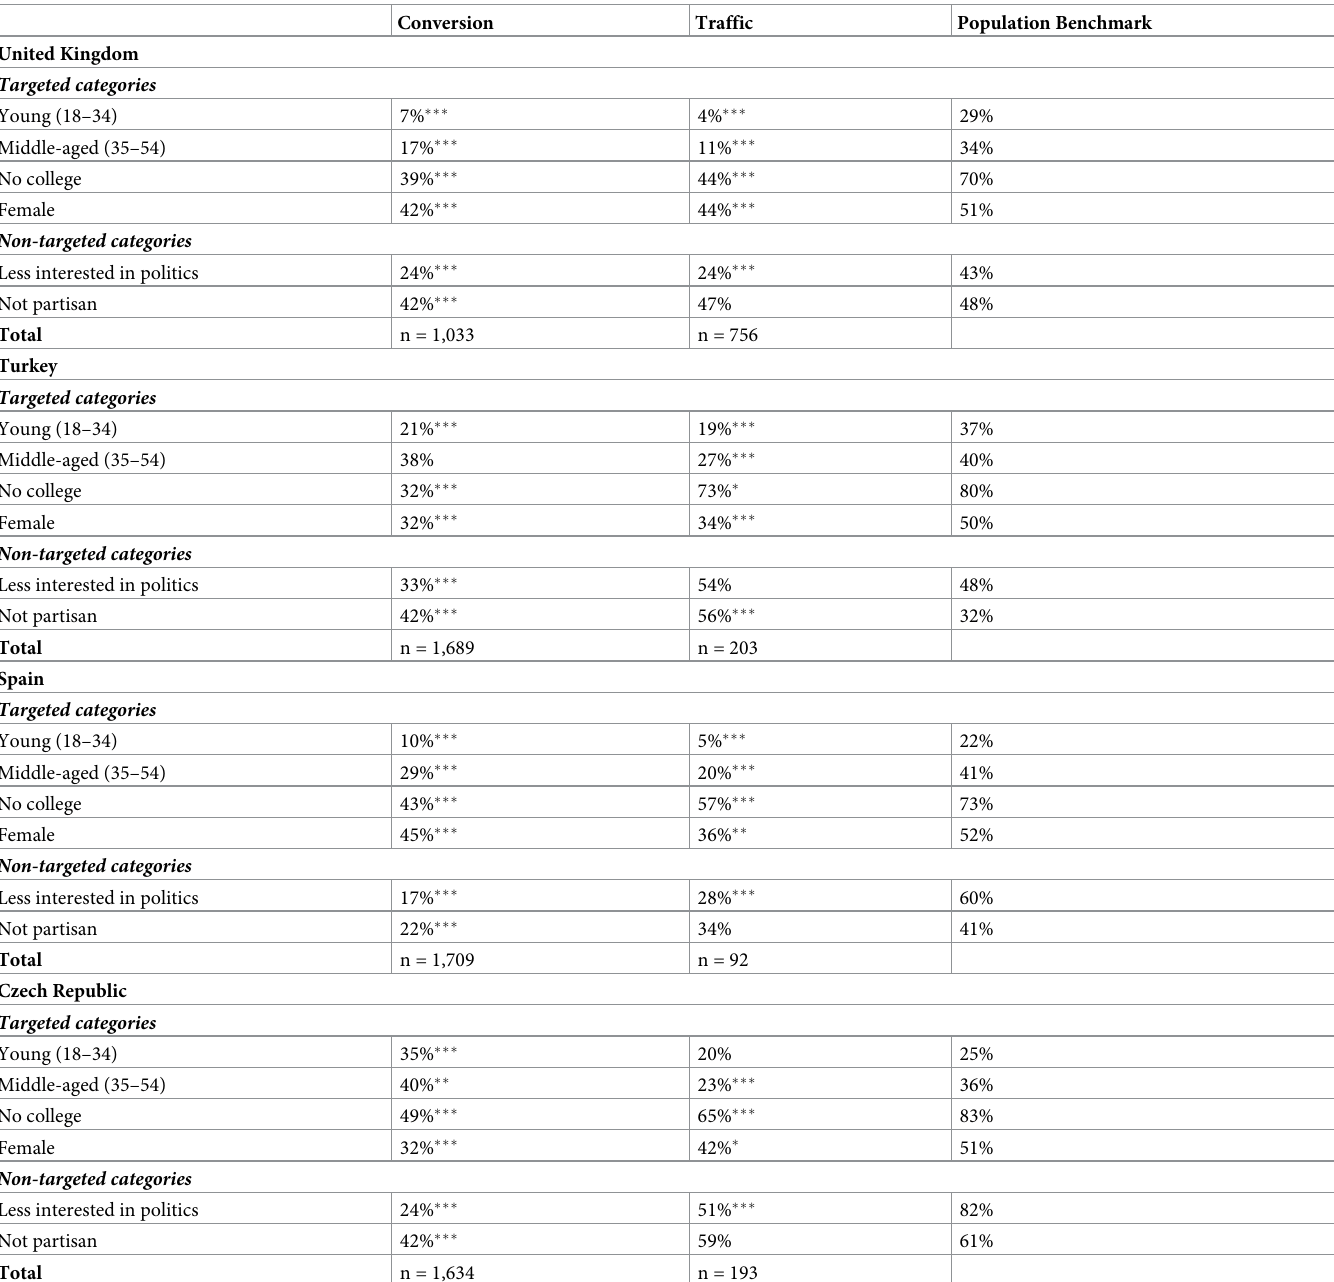
Table 3. Sample characteristics for conversion and traffic campaigns for survey